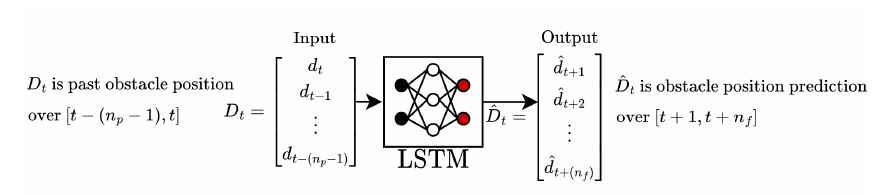
Figure 2. Architecture of LSTM network for position